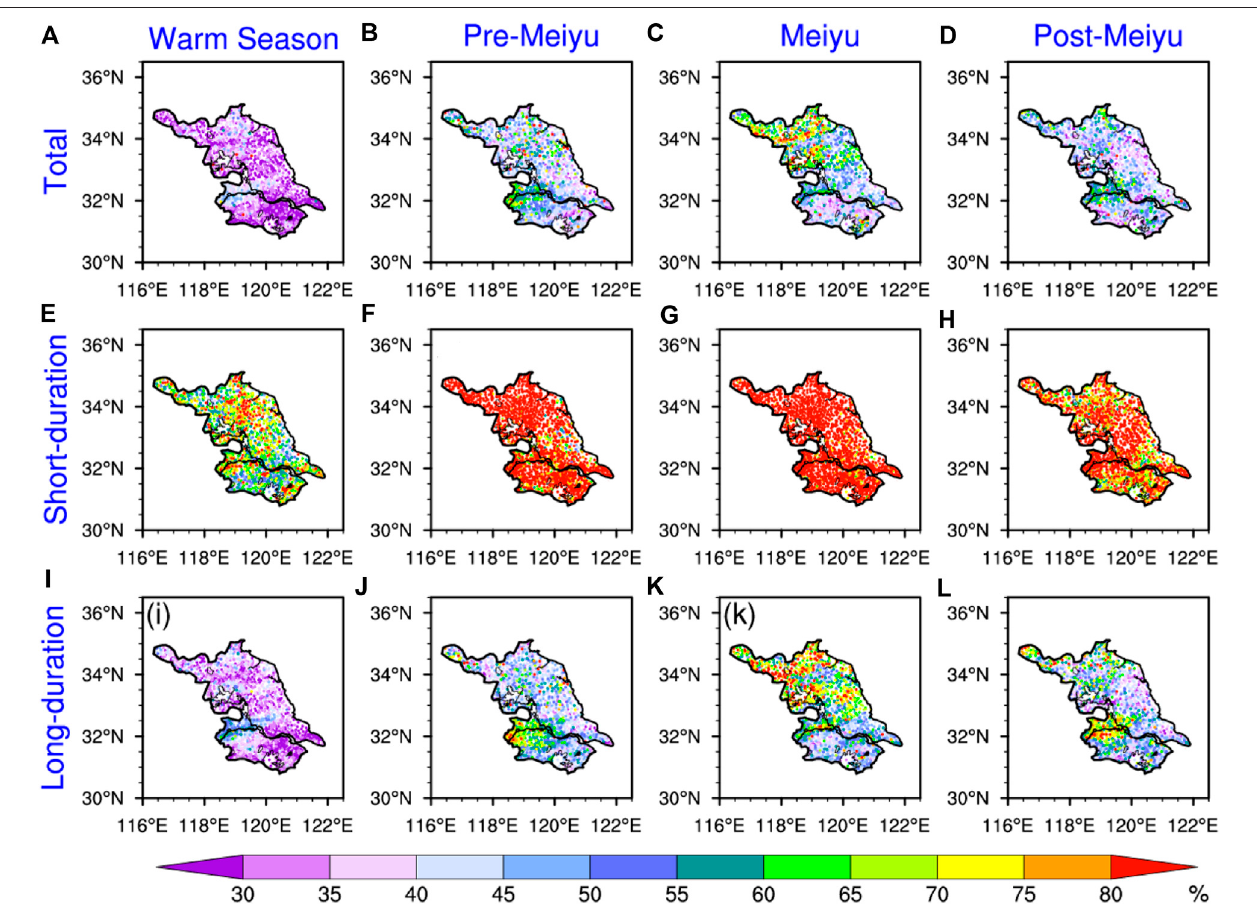
FIGURE7 | Spatial distributions ofPDV for total PA (A-D) , short-duration rainfall PA (E-H) and long-durationrainfallPA (G-I) in warm season and each sub-period of warm season (four rows separately represent Warm season, Pre-Meiyu, Meiyu and Post-Meiyu period) averaged over 2013 – 2017.